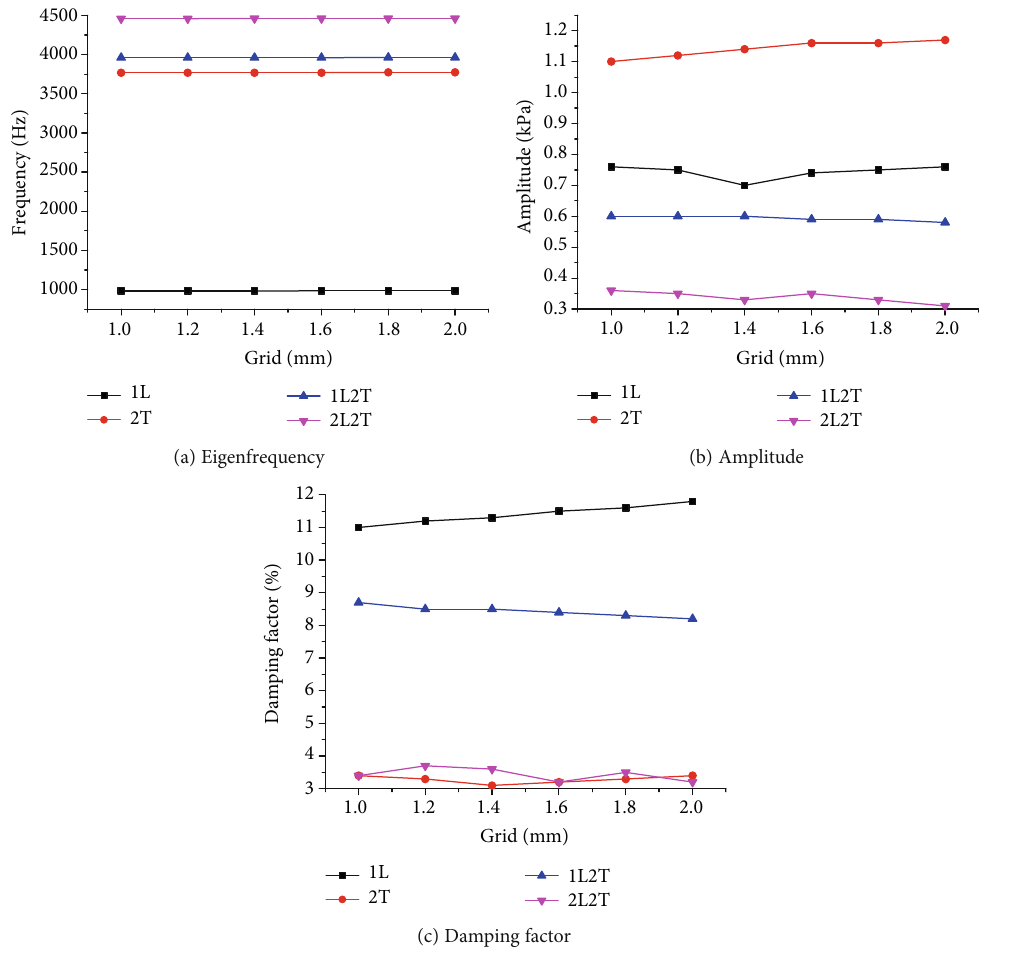
Figure 4: Acoustic performances of the chamber with di ff erent grid sizes.